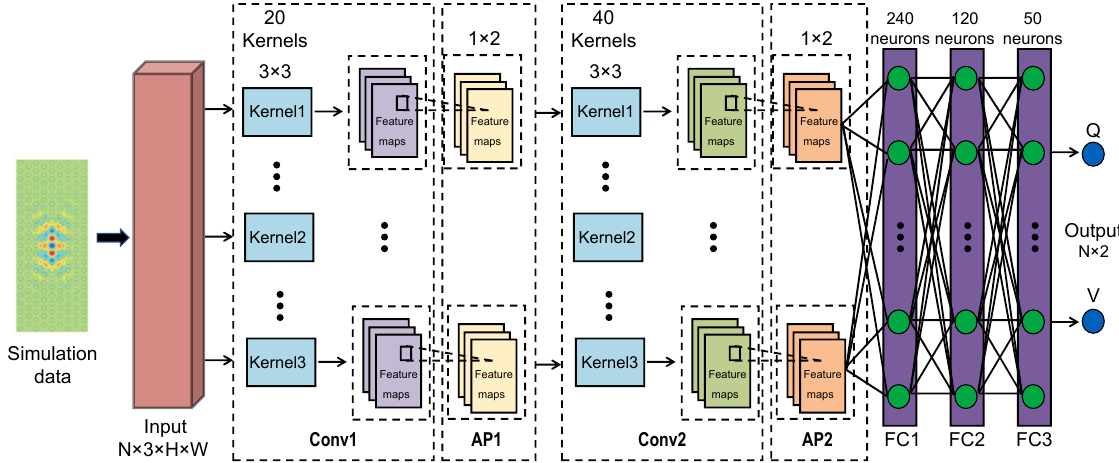
Figure 1. The DNN model (LRS-RCNN) to correlate the input (i.e., design parameters) with output (i.e., optical parameters such as Q and V ) of nanophotonic structures. LRS-RCNN consists of two convolutional layers (Conv1 and Conv2), each accompanied by an averaging pooling (AP) operation, and lastly three FC layers. LRS-RCNN tackles the prediction of optical properties as a deep learning regression problem. The detailed specifications of the network and its hyperparameters are marked on the diagram and/or listed in Table